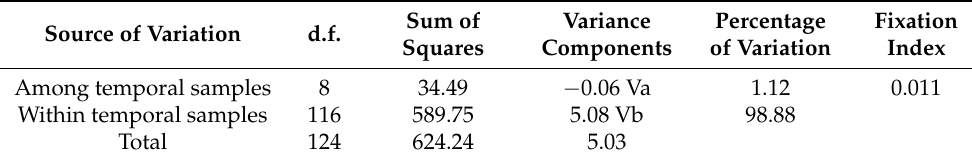
Table 3. Analysis of Molecular Variance (AMOVA) results for Japanese